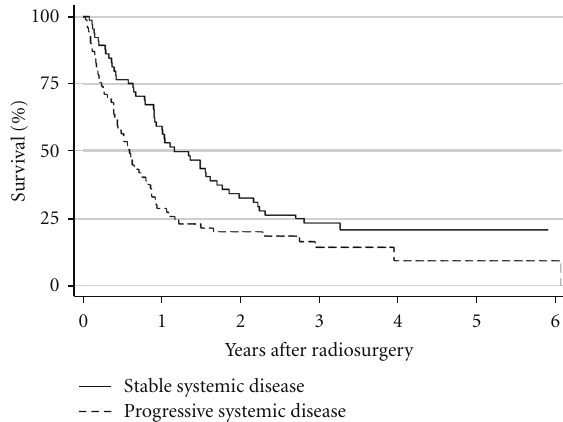
Figure 4: Kaplan-Meier plot of overall survival after GK-SRS for all 133 patients, stratified by the presence of progressive systemic disease at the time of